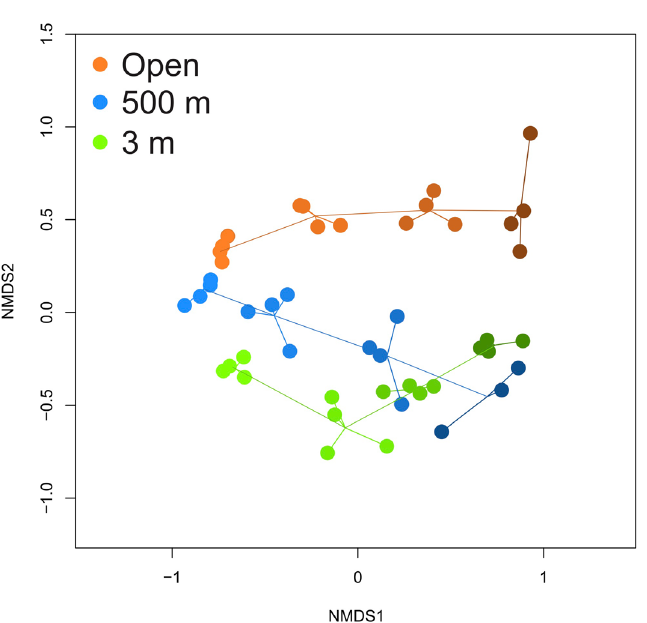
Figure 2. Trajectories of the bacterial communities. The similarity between bacterial communities growing in the wood is represented by an MDS ordination based on the Bray–Curtis index. Color group communities sampled from a same inoculation treatment. The intensity of the color is proportional to the time elapsed sinceincubation started (8 days, 19 days, 28 days and 40 days, the darker the